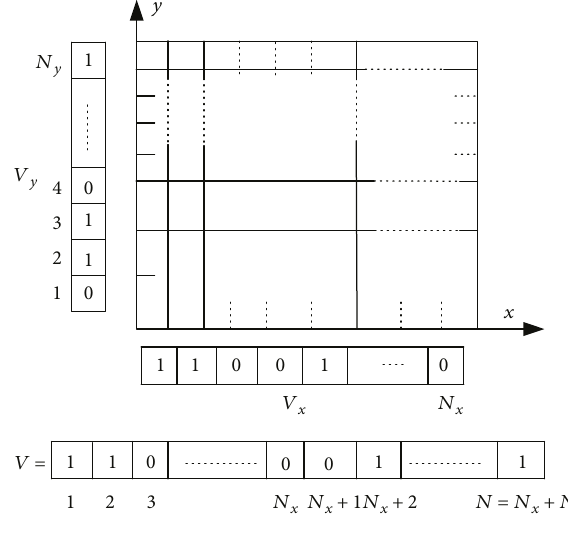
Figure 12: Representation of individuals.